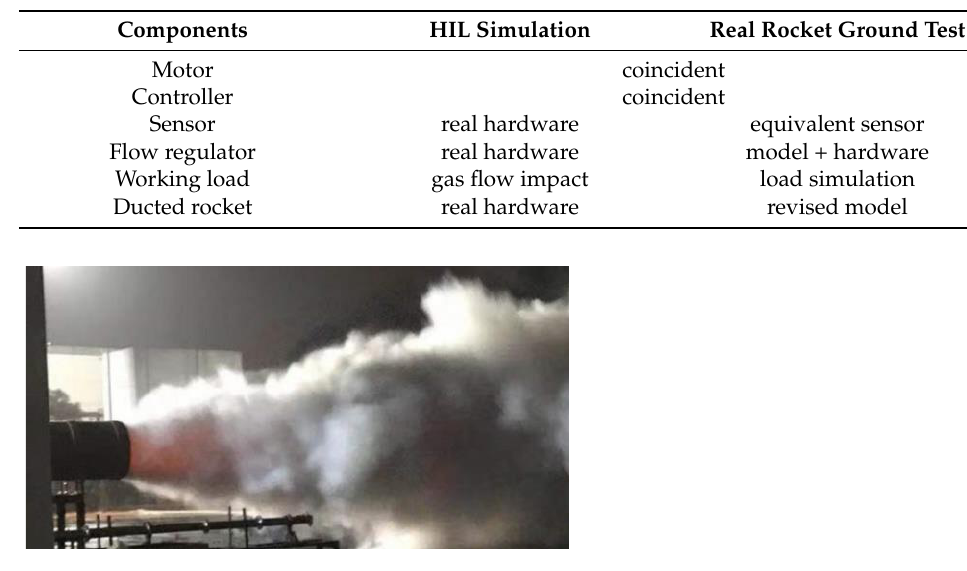
Figure 14. Direct-connected ground test of a ducted rocket [12].